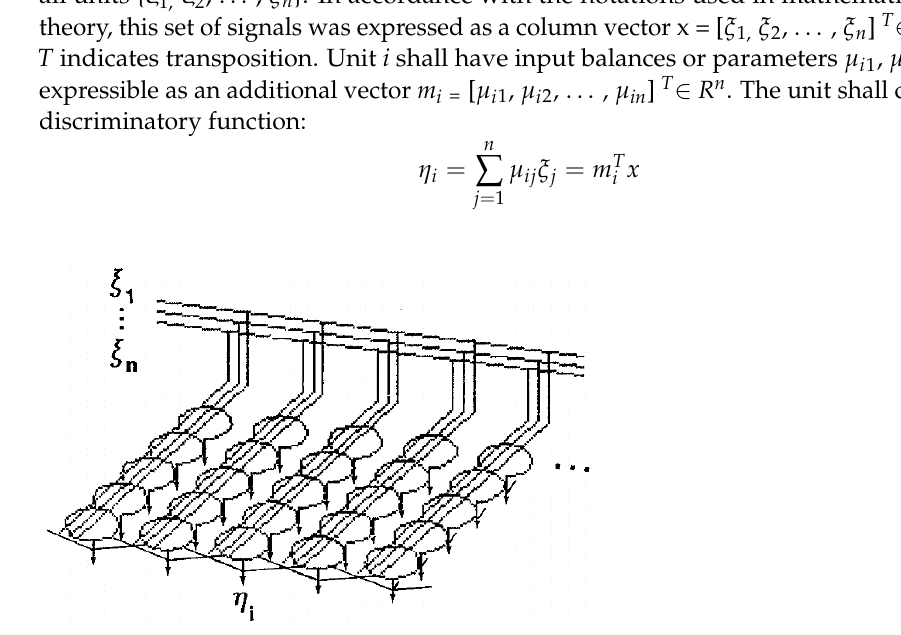
Figure 2. Two-dimensional array of processor units. Source: (Kohonen 1982).